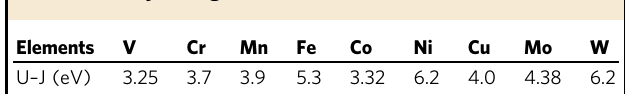
Table 3 List of U − J parameters. Values except for Cu are used in the Materials Project 18 , and the value for Cu is determined by Weng et al. 77